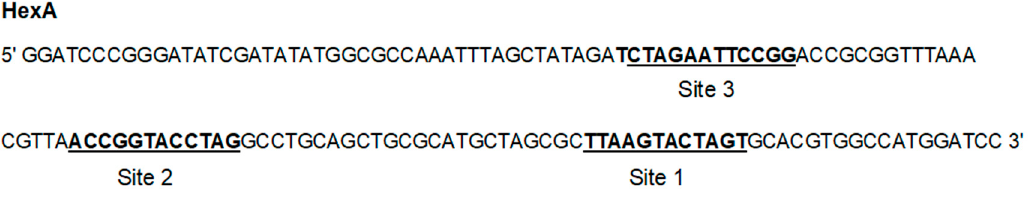
Figure 3. DNA sequences (underlined) of the footprinting substrates indicating the regions protected by the ligand from DNase I cleavage.